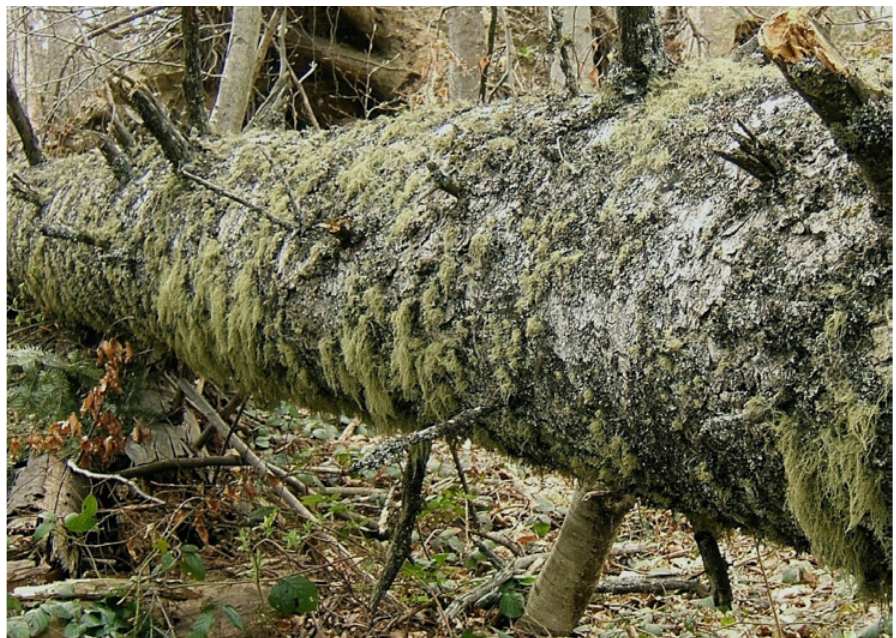
Fig. 3. A blown-down tree-trunk covered with Usnea